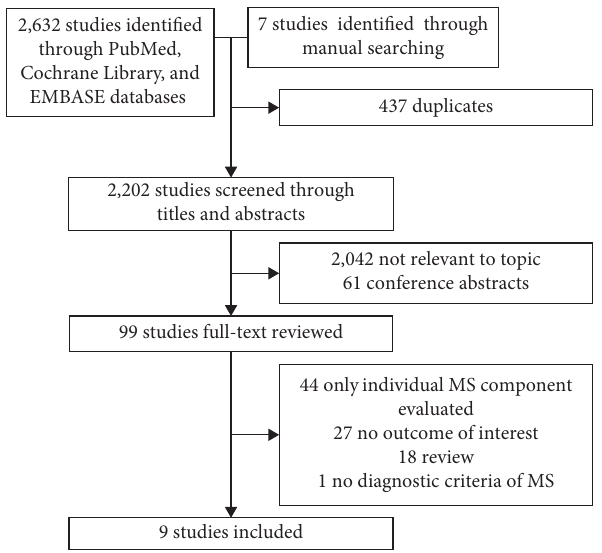
Figure 1: Results of information